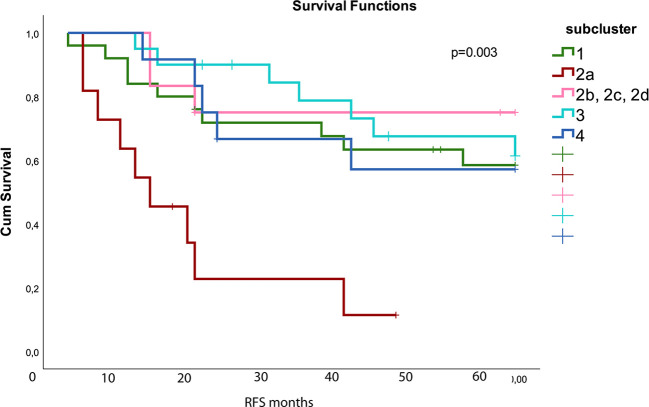
Kaplan Meier survival plot shows that subcluster 2a (red) had worse relapse free survival (RFS) compared to the other subclusters (p=0.003). The different subclusters are generated from the hierarchical clustering in
Figure 1
. Subcluster 2b contains 2b, 2c, and 2d shown with pink color. The colors used for the subclusters correspond to the color used for the subclusters in
Figure 1
. Number of samples in the different subclusters are: subcluster 1 n = 25, 2a: n=11, 2b/2c/2d: n = 12, 3: n = 20, and 4: n=12.